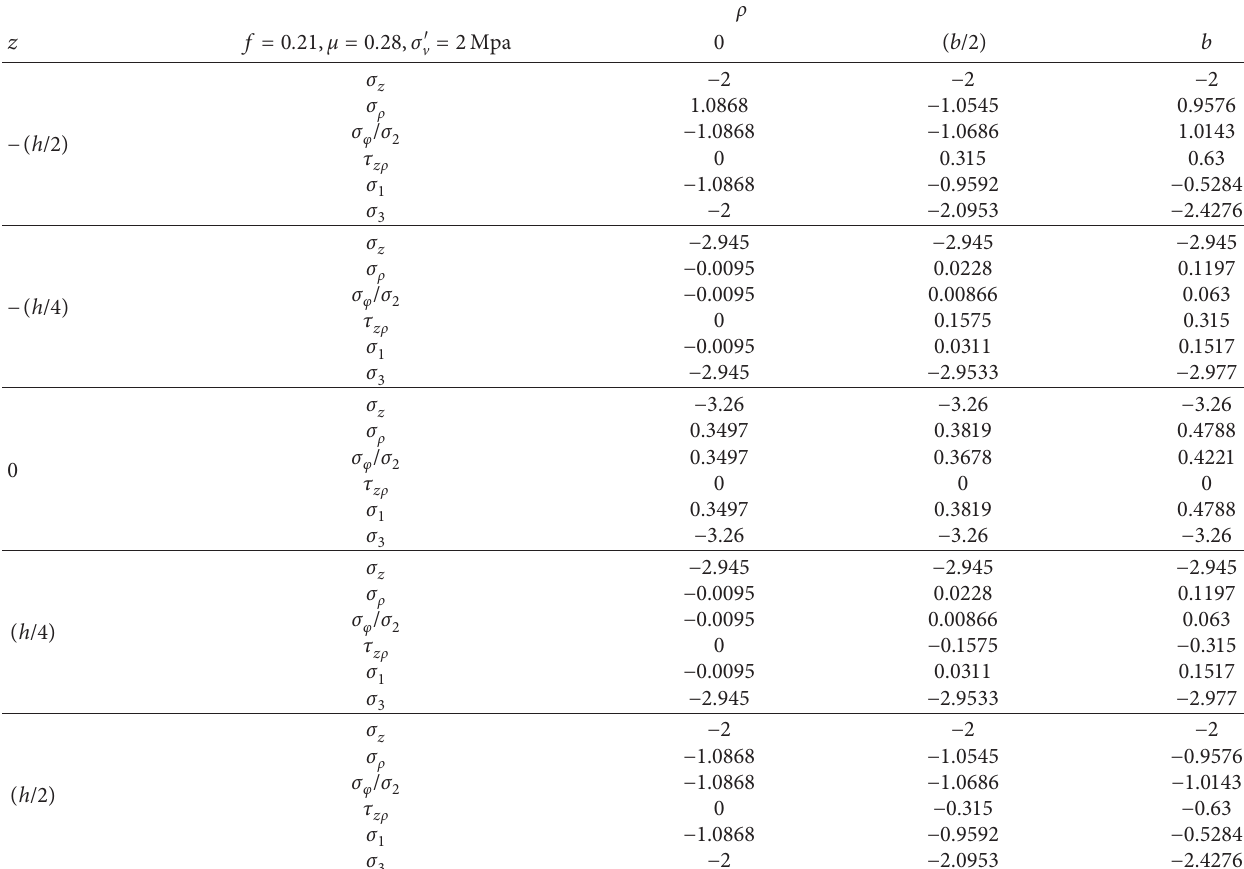
Table 1: Stress distribution details of sample internal key points (unit of stress: